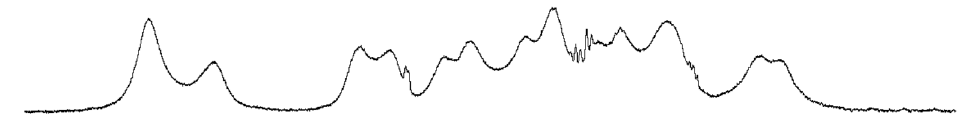
Figure 7. 500 MHz 1 H NMR spectra of a solution ( a ) containing 15 mg of py 2 CO dissolved in 0.5 mL of D 2 O (99.8%), ( b ) solution (a) + 10 µL of 5% DCl/D 2 O, ( c ) solution ( b ) + 25 µL of 5% DCl/D 2 O, showing changes in the equilibrium of the keto carbonyl group (py 2 CO) to gem-diol (py 2 CO · H 2 O).